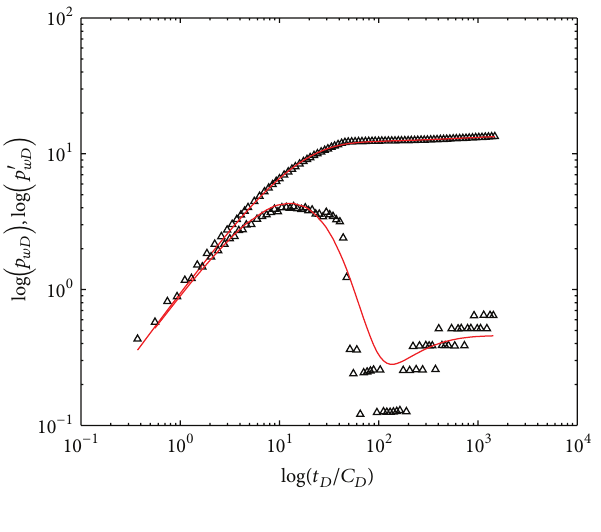
Figure 12: Field test data and history matching of type curves (Field Test Two: Well